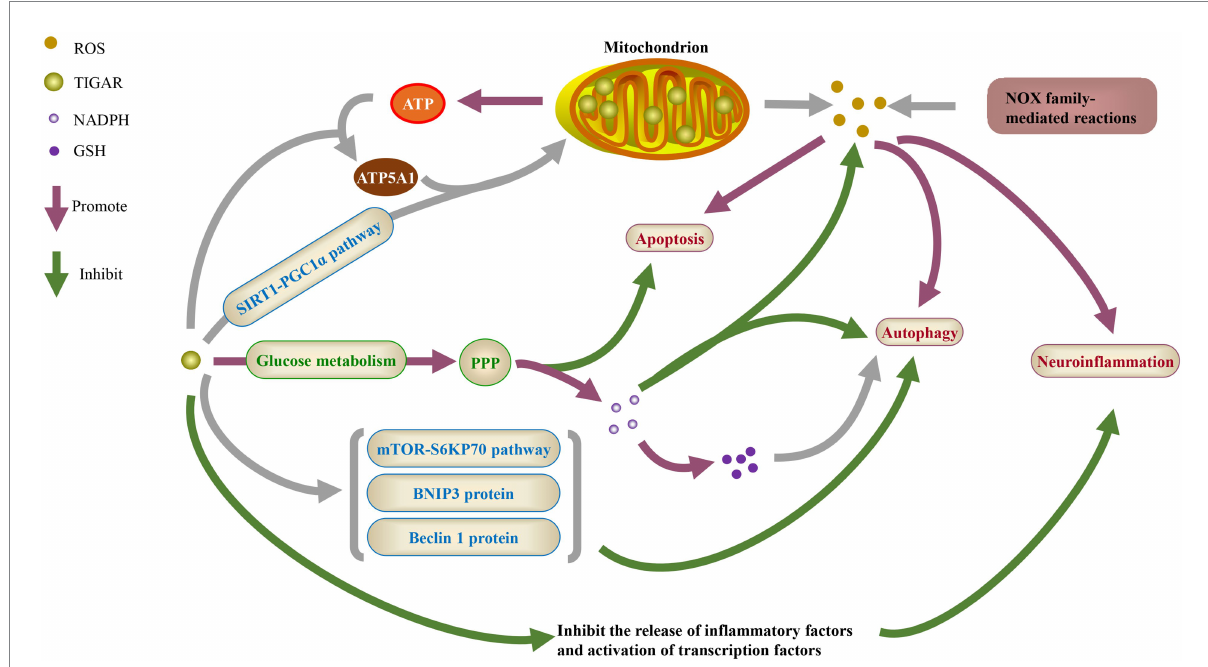
FIGURE 1 The physiological function of TIGAR. ROS, reactive oxygen species; NADPH, nicotinamide adenine dinucleotide phosphate; GSH, glutathione; ATP, adenosine triphosphate; ATP5A1, ATP synthase F1 subunit a; SIRT1, sirtuin 1; PGC1 α , peroxisome proliferator-activated receptor γ coactivator 1 α ; PPP, pentose phosphate pathway; mTOR, mammalian target of rapamycin; BNIP3, BCL-2/adenovirus E1B 19KD interacting protein 3; NOX, NADPH